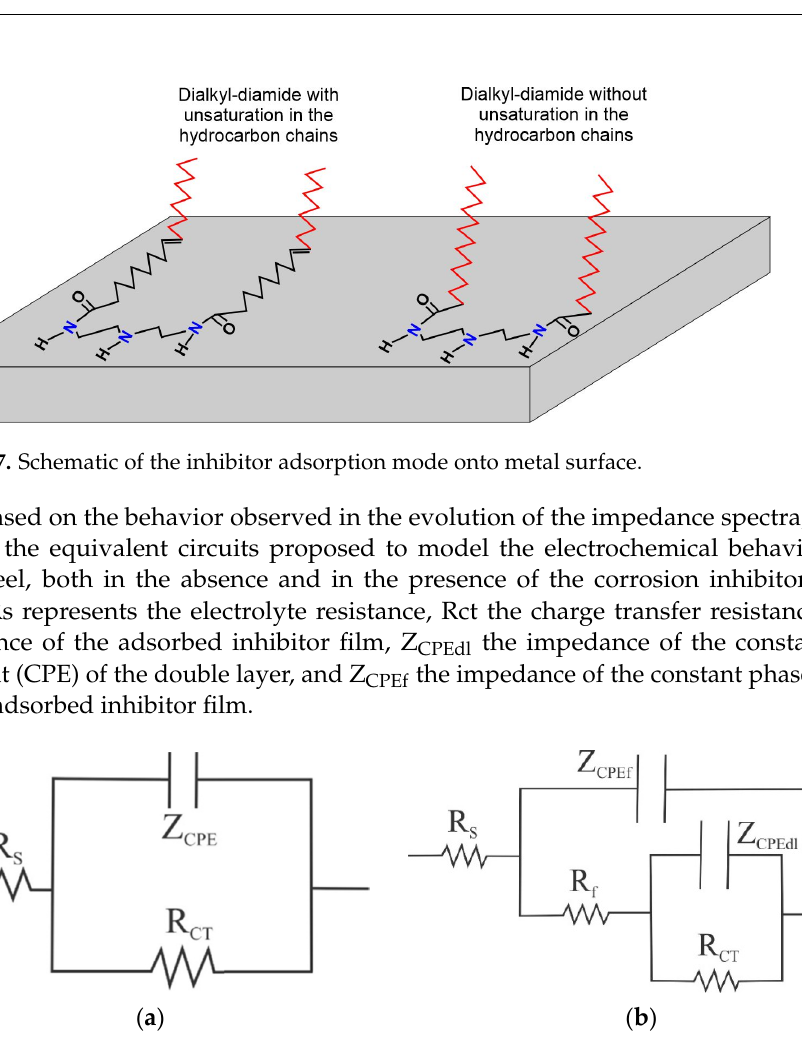
Figure 7. Schematic of the inhibitor adsorption mode onto metal surface.